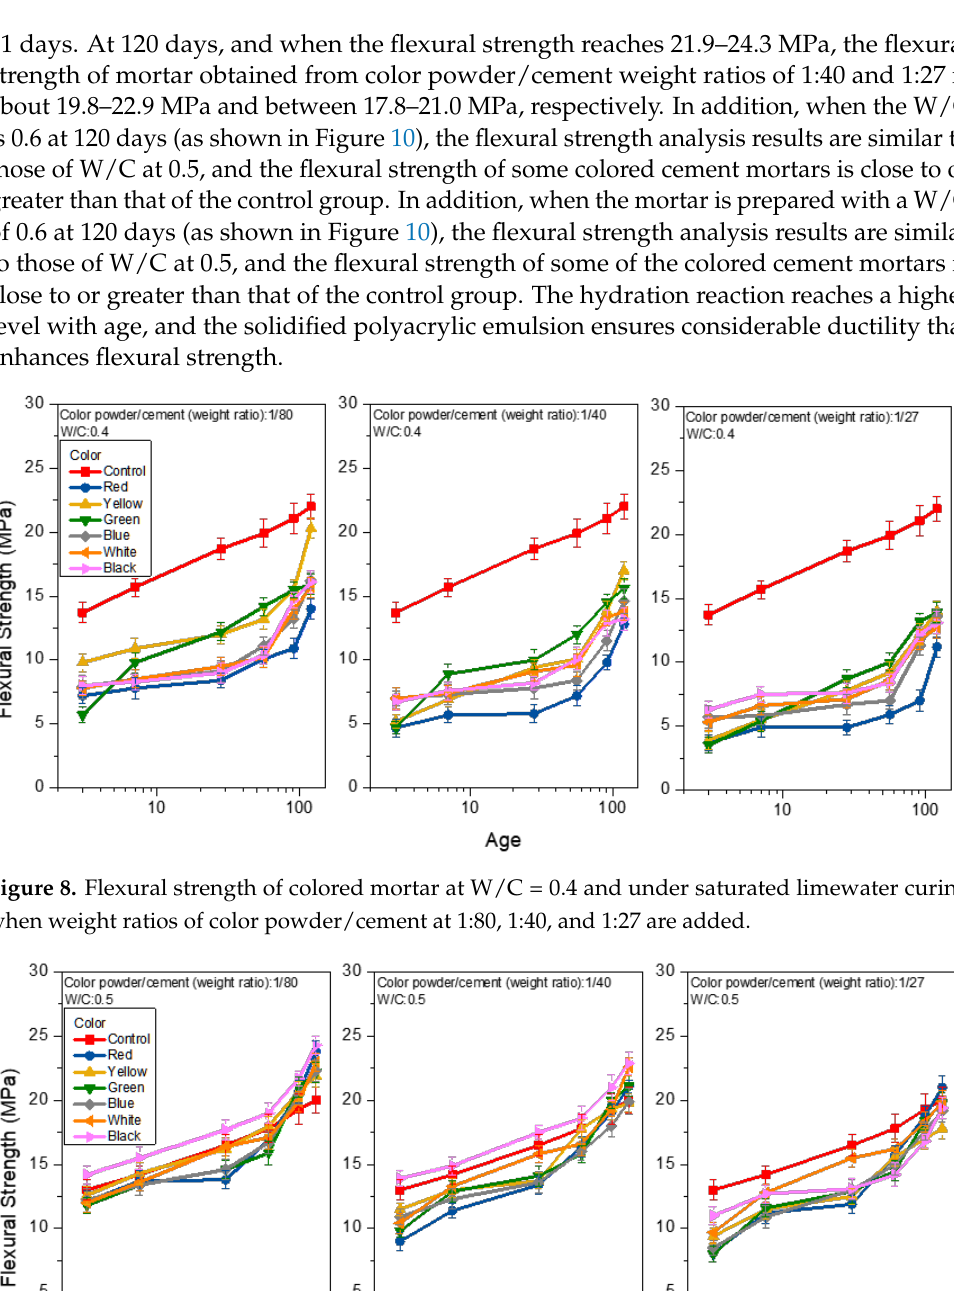
Figure 10. Flexural strength of mortar at W/C = 0.6 and under saturated limewater curing when weight ratios of color powder/cement at 1:80, 1:40, and 1:27 are added.